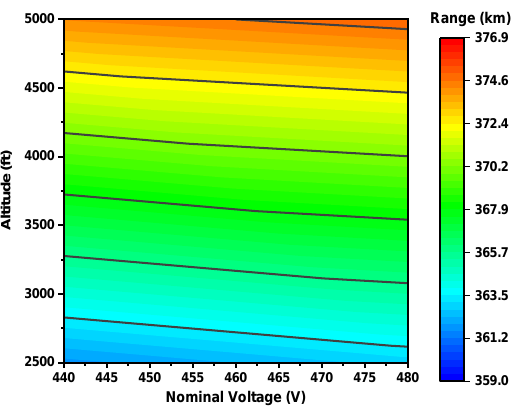
Figure 10. Hybrid electric altitude vs. voltage range comparison: 10 kg cases only (ICE-only cruise).